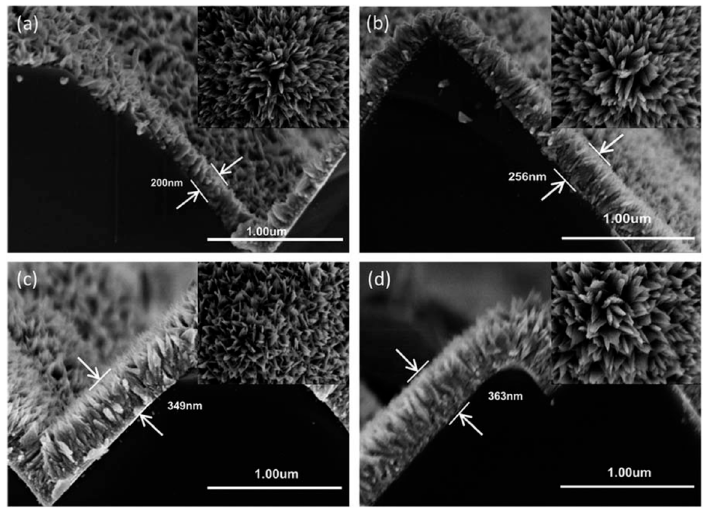
Figure 13. Cross-sectional field emission scanning electron microscope image of CuO NL grown on pyramid-textured Si substrates for ( a ) 30 min; ( b ) 45 min; ( c ) 60 min; and ( d ) 90 min in a two-step process. Inset of each image shows the corresponding top view. Reproduced in part from J, Mater.